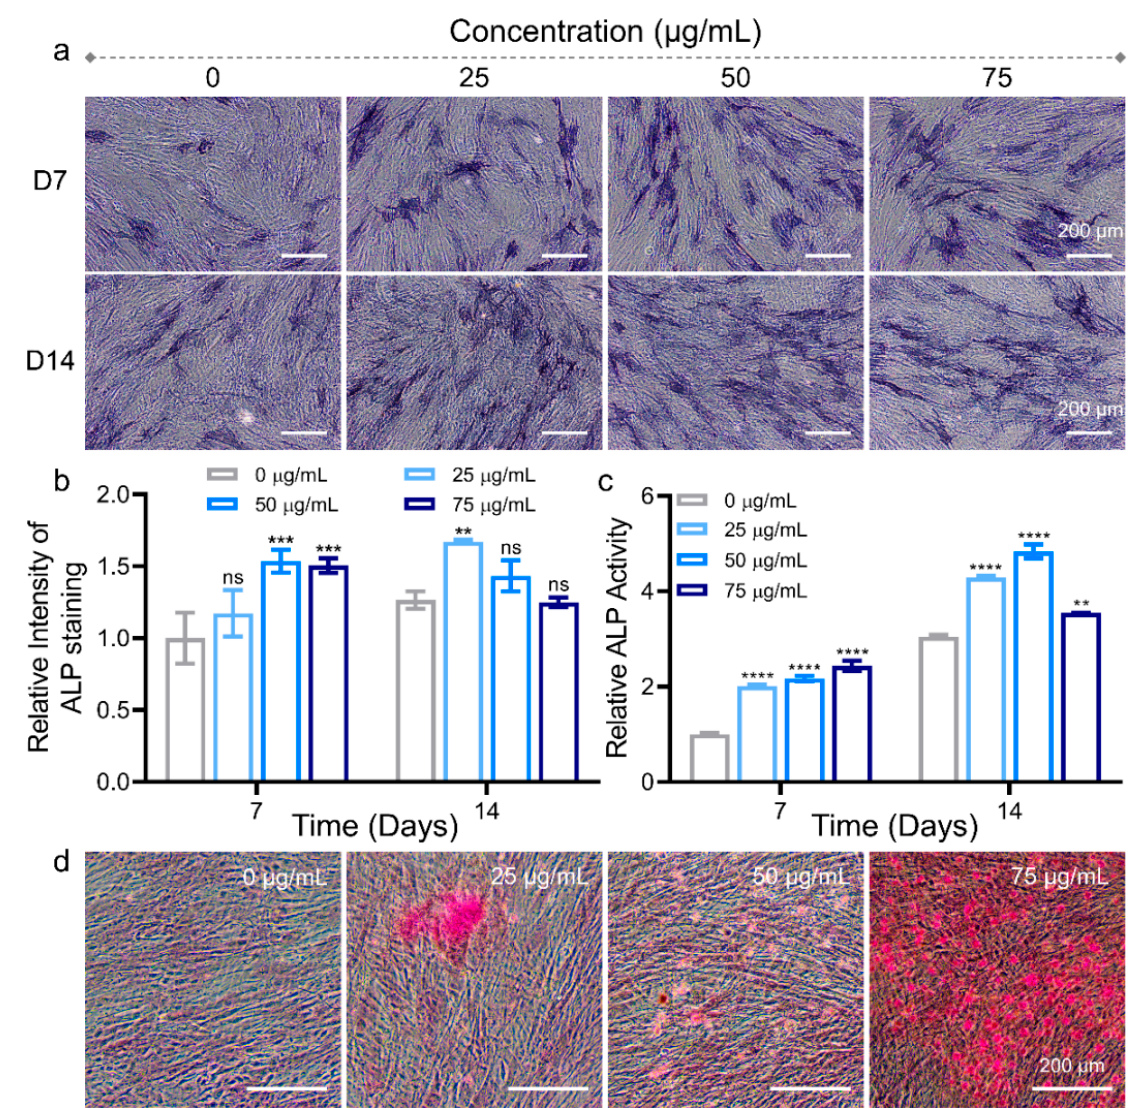
Figure 6. Identification of alkaline phosphatase (ALP) and mineralized nodules in osteoblasts. ( a ) ALP staining images on Days 7 and 14 after being cultured with 0, 25, 50, and 75 μ g/mL MNPs. ( b ) Quantitative analysis of ALP staining intensity after being cultured with different concentrations of MNPs. Data represent mean ± standard deviation ( n = 3). Significance was determined by two-way ANOVA (** p < 0.01, *** p < 0.001, ns: not significant vs. the 0 μ g/mL group at 7 days). ( c ) Relative ALP activity after 7 and 14 days when cultured with 0, 25, 50, and 75 μ g/mL MNPs. Data represent mean ± standard deviation ( n = 3). Significance was determined by two-way ANOVA (** p < 0.01, **** p < 0.0001, vs. the 0 μ g/mL group at 7 days). ( d ) Alizarin Red S staining images of hADSCs cultured with 0, 25, 50, and 75 μ g/mL MNPs after 14 days.